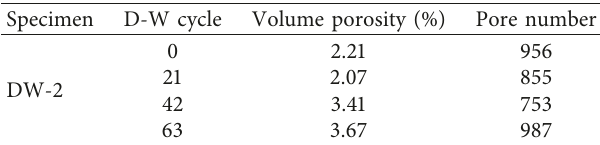
Table 3: Statistical results of pore characteristics of DW-2 exposed to drying-wetting cycles with sulfate